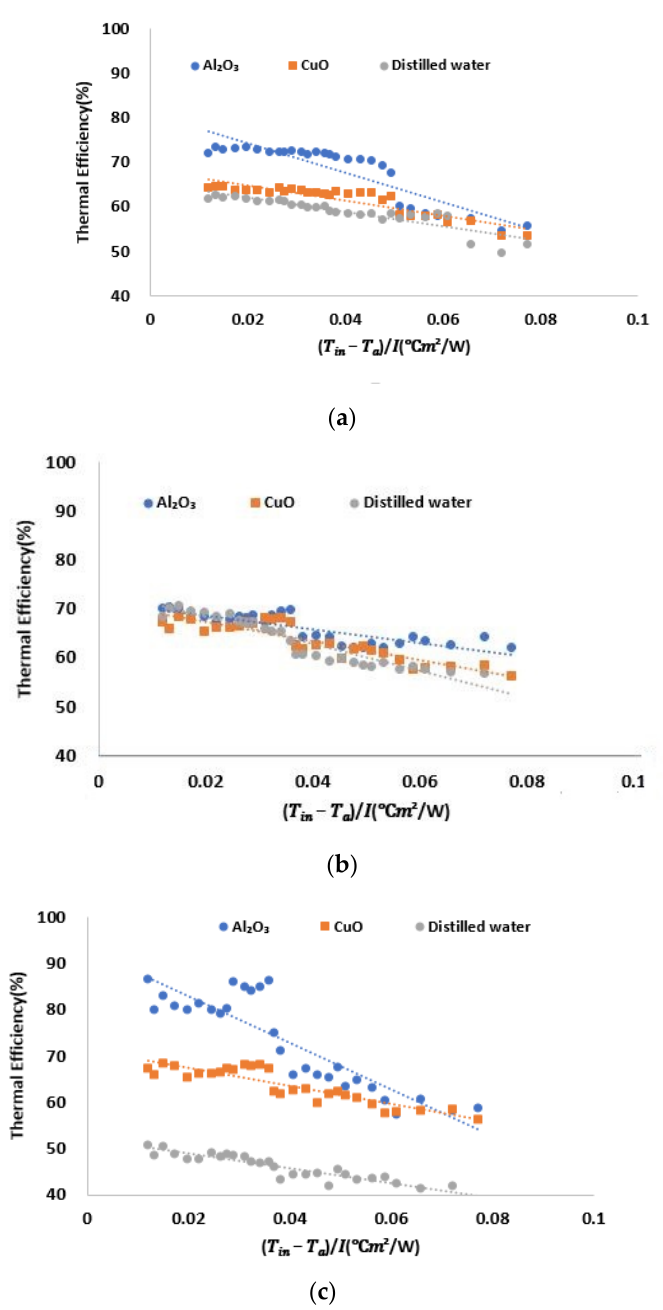
Figure 5. Reduced zero temperature efficiency at ( a ) 2 L/min, (b) 4 L/min, and ( c ) 6 L/min.